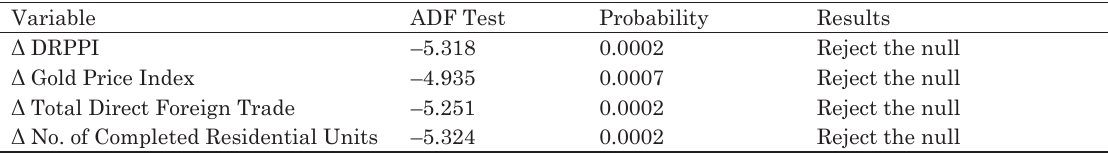
table 3. summary of aDf tests for unit roots in the variables (in 1 st difference from with a trend and